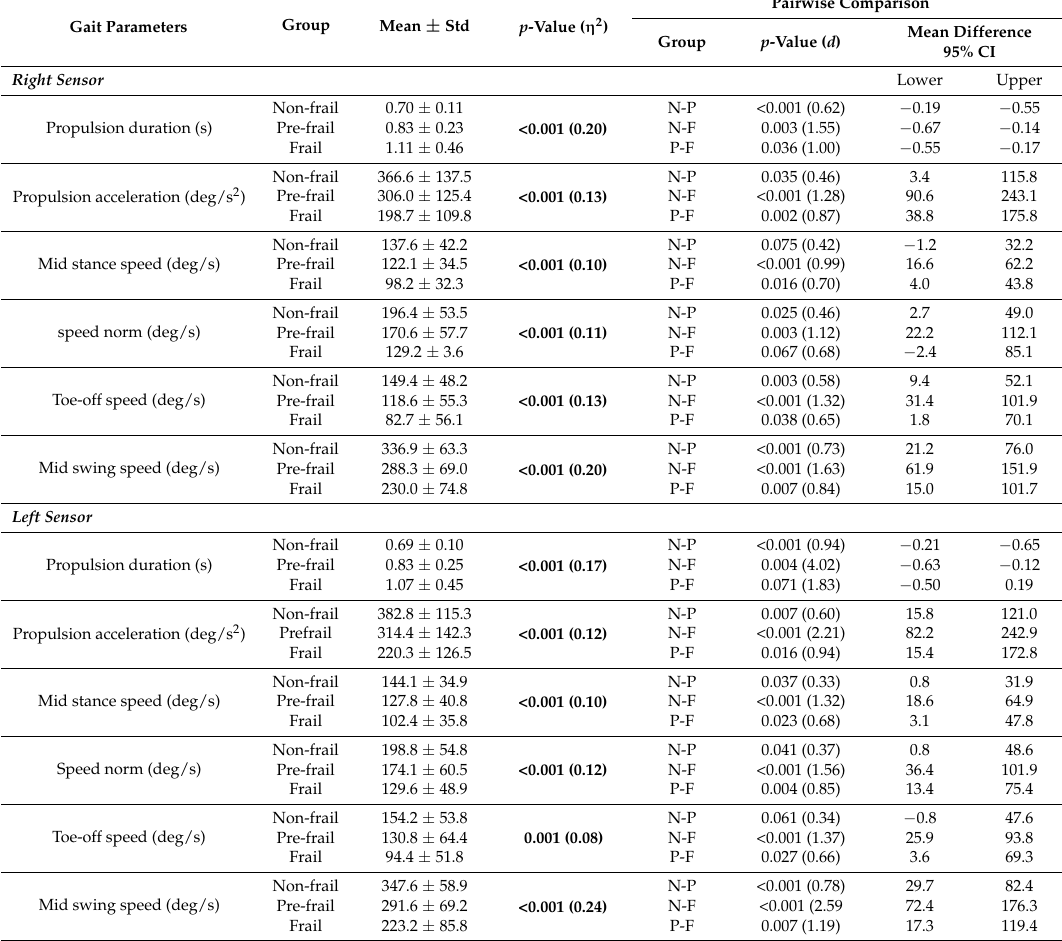
Table 3. Sensor-derived gait parameters during single walking task across three